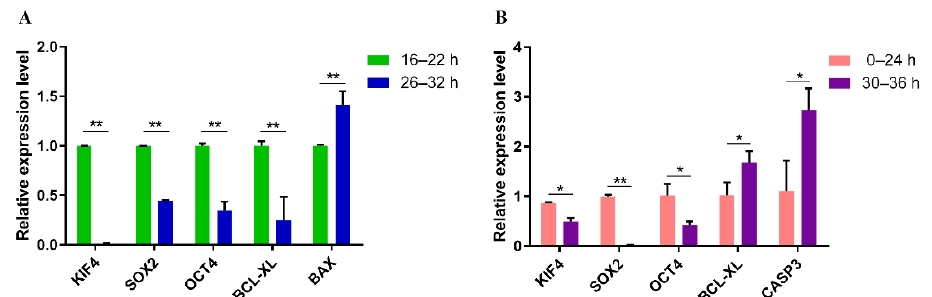
Figure 5. The relative mRNA abundance of some important genes. ( A ) Relative expression levels of pluripotency- and apoptosis-related genes of blastocysts in early and late cleavage PA embryos. ( B ) The relative expression levels of pluripotent and apoptosis-related genes in early and late cleavage IVF 2-cell embryos. *: p < 0.05; **: p < 0.01.